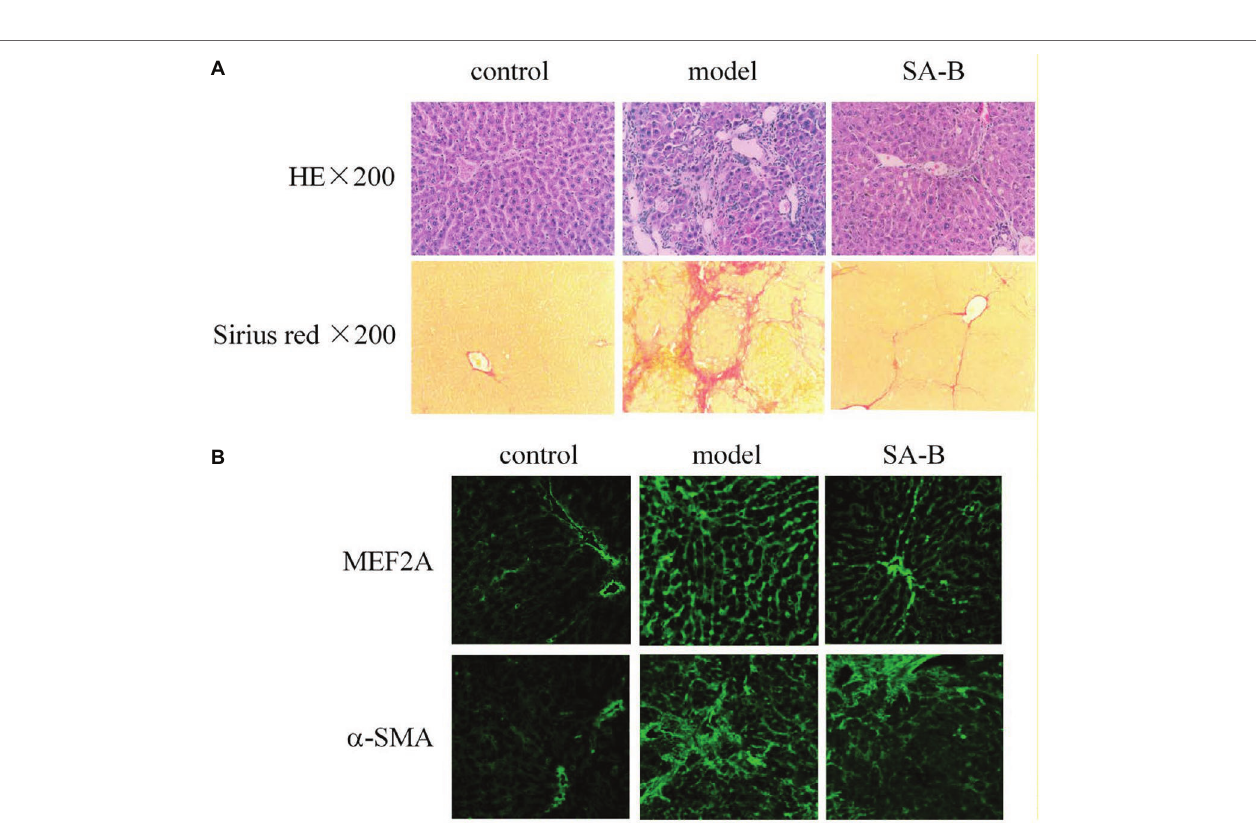
FIGURE 5 | Reduction of the expression of MEF2s and markers of H-HSC activation by SA-B. (A) Expression of Col I and α -SMA in H-HSC treated with SA-B or TGF- β 1. Day 5 H-HSCs were treated with SA-B (1 μM) for 48 h, and then treated with TGF- β 1 (10 ng/ml) for 2 h ( n = 3; ** p < 0.01; Col I and α -SMA induced by TGF- β 1 pretreated with SA-B vs. non-treated). The collagen luciferase reporter gene assay was determined. Relative fold change in luciferase activity is shown ( n = 3, ** p < 0.01, wild-type reporter induced by TGF- β 1 with SA-B treatment vs. without SA-B treatment). (B) Expression of MEF2 in H-HSC treated with SA-B. Day 5 H-HSCs were treated with SA-B at different concentrations for 48 h. Protein level was analyzed by western blot (top left panel). Densitometry values of MEF2 relative to β -actin are shown (top right panel) ( n = 3; ** p < 0.01 vs. non-treated with SA-B). The MEF2 mRNA expression was determined by RT-qPCR following SA-B (1 μM) treatment as described above (bottom left panel) ( n = 3, ** p < 0.01, with vs. without SA-B). The MEF2-dependent luciferase reporter gene assay was determined (bottom right panel: n = 3; ** p < 0.01, wild-type reporter treated with SA-B vs. without SA-B). (C) Expression and activity of MEF2 treated with SA-B or TGF- β 1. Day 5 H-HSCs were treated with SA-B (1 μM) for 48 h and then treated with TGF- β 1 (10 ng/ml) for 2 h. Protein level of MEF2 was determined by western blot (top left panel) ( n = 3; ** p < 0.01, TGF- β 1-treated samples with SA-B vs. without SA-B). MEF2 mRNA expression and reporter activity assay was determined (bottom panel) ( n = 3; ** p < 0.01, TGF- β 1 treated samples pretreated with SA-B vs. without